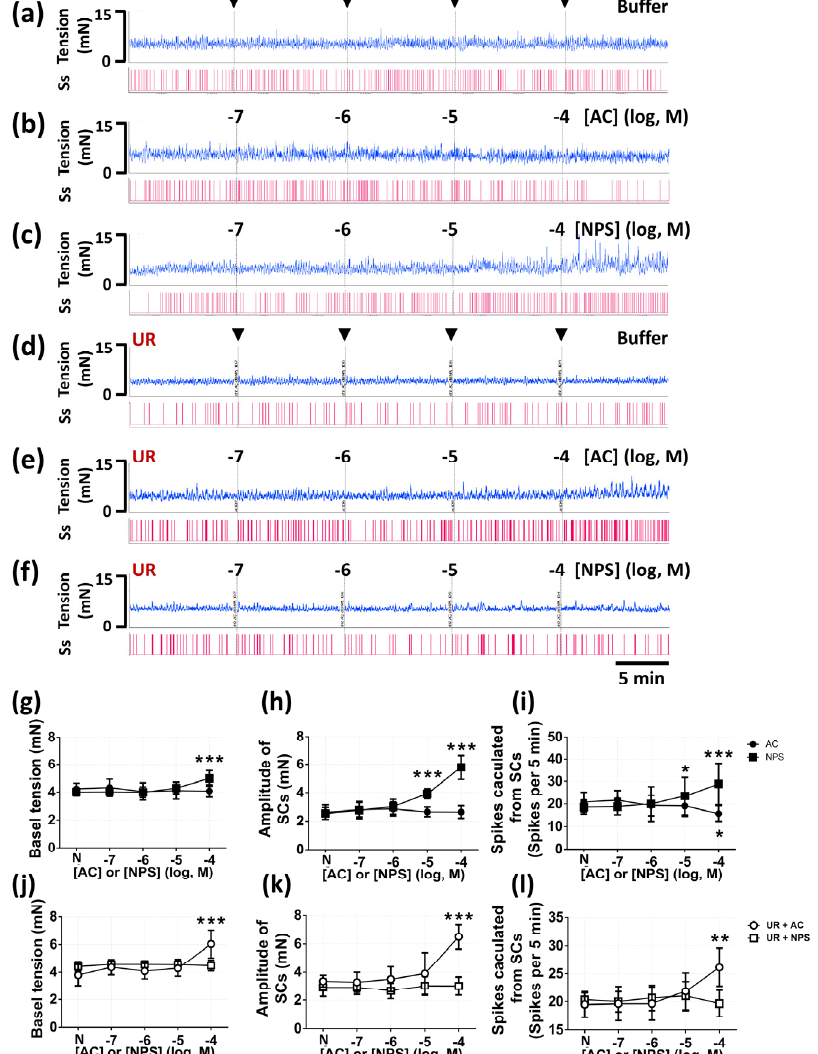
± 3.07, p = 0.0297; 28.8 ± 9.19 vs. 18.6 ± 3.07, p < 0.0001), and AC (100 μ M) significantly decreased the number of spikes (15.8 ± 3.43 vs. 20.8 ± 4.35, p = 0.0374), as compared with the normal status (N) (Figure 2i). Interestingly, in the groups of the urothelium removal (UR) bladder strips ( n = six per group), we found that AC (100 μ M) significantly increased the basal tension (6.05 ± 1.08 vs. 3.79 ± 0.77 mN, p < 0.0001) (Figure 2j), the amplitude of SCs (6.51 ± 0.86 vs. 3.35 ± 0.42 mN, p < 0.0001) (Figure 2k), and the number of spikes (26.16 ± 3.43 vs. 19.50 ± 2.25, p = 0.0022) (Figure 2l), as compared with the normal status (N). Moreover, NPS did not demonstrate obvious effect on smooth muscle tension, the amplitude of SCs, and the number of spikes in the urothelium removal (UR) bladder strips (all p > 0.9999), as compared with the normal status.